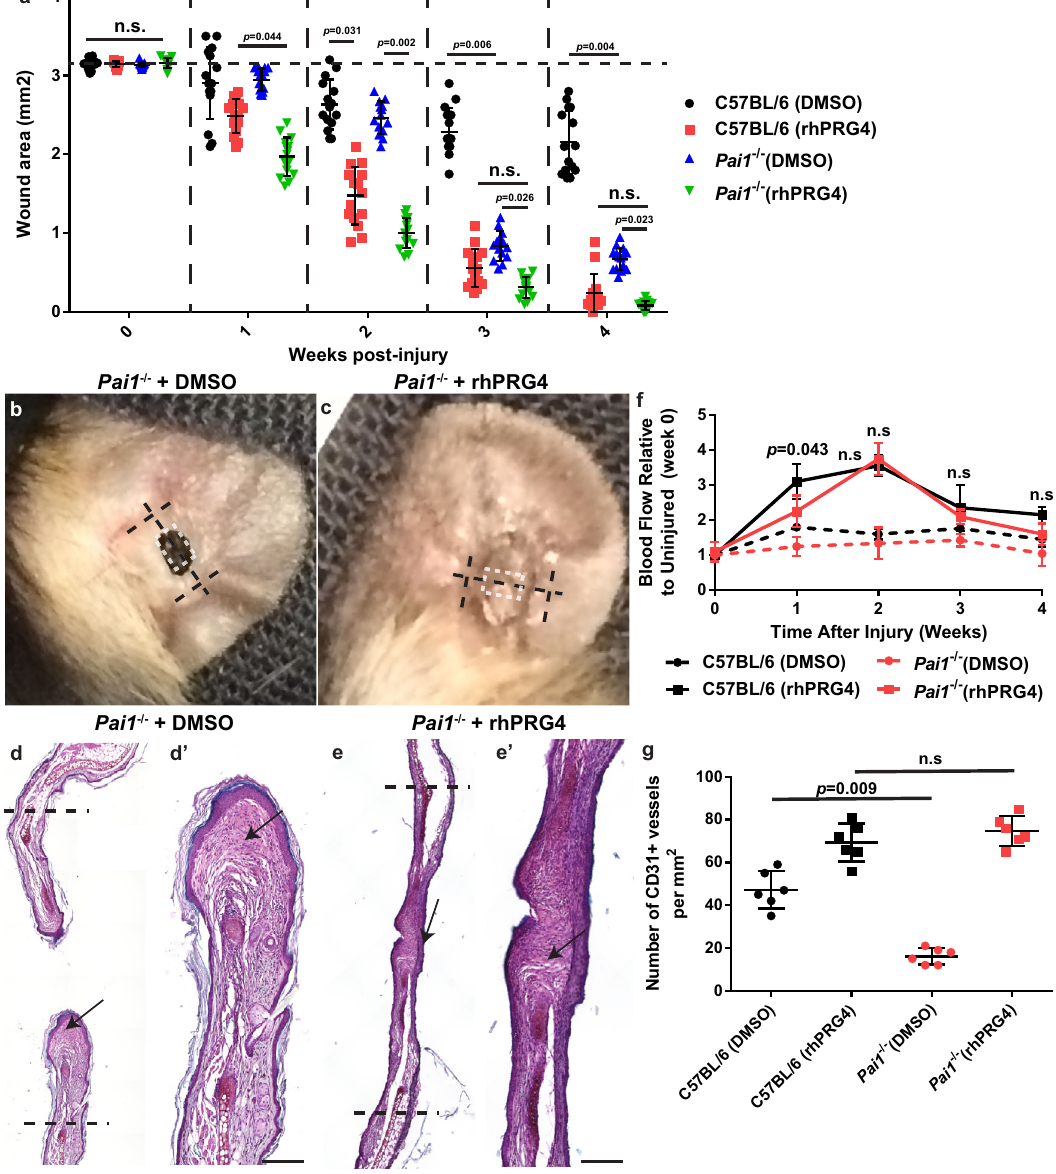
Fig. 5 Pai1 − / − mice demonstrate increased wound healing post-injury. Pai1 − / − mice demonstrate increased wound closure compared to C57BL/6 mice and this is enhanced in the presence of rhPRG4 a . Representative images of ears 4 weeks post-injury b , c . The black dashed line represents the plane of histological sectioning which the original injury diameter, while the white dashed box indicates the location of the histological image presented b , c . Representative histological images stained with Safranin O, 4 weeks post-injury d , e . Minimal new cartilage can be observed in Pai1 − / − mice treated with DMSO (arrows, d ). Although the wound completely closed in Pai1 − / − mice treated with rhPRG4, new cartilage is absent from the wound area (arrow e ) yet is present at the injury boundary. Quantitative analysis of blood fl ow data demonstrates that Pai1 − / − mice treated with DMSO have no increase in blood fl ow at the wound area post-injury f . Furthermore, the number of CD31 + blood vessels is decreased in the wound area site of Pai1 − / − mice g . Scale bar equals 50 µm. n.s. = not signi fi cant. Error bars equal mean ± SD ( f , g – 1 way ANNOVA, a – 2 way ANNOVA). Sample sizes: a-f, n = 15 per group; g – i , n = 6 per